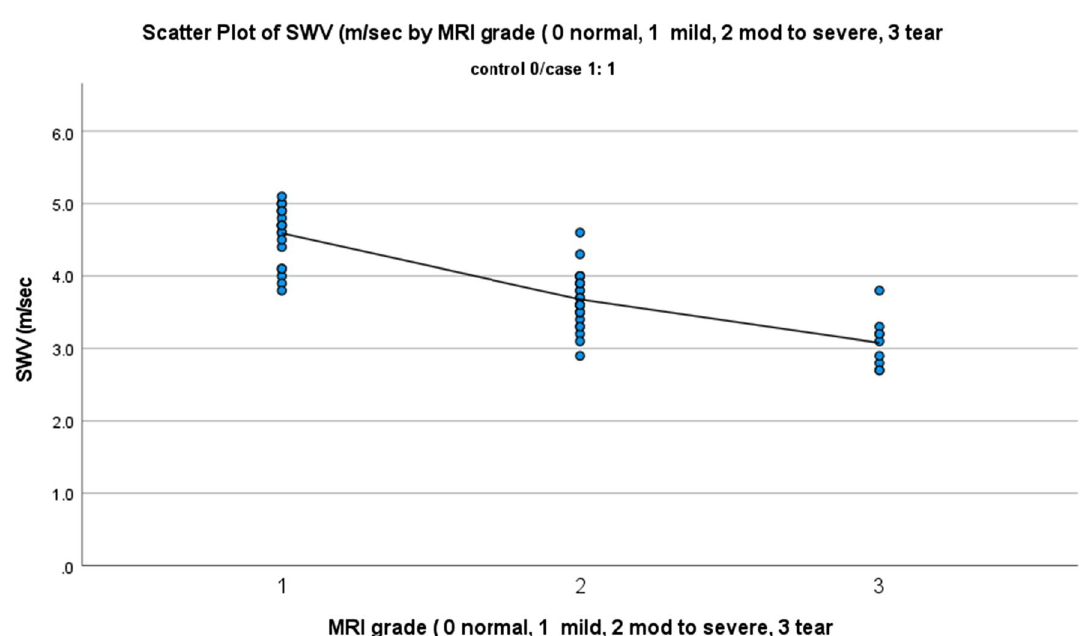
Fig. 7 Correlation between different MRI grades and the measures SWV (significant negative